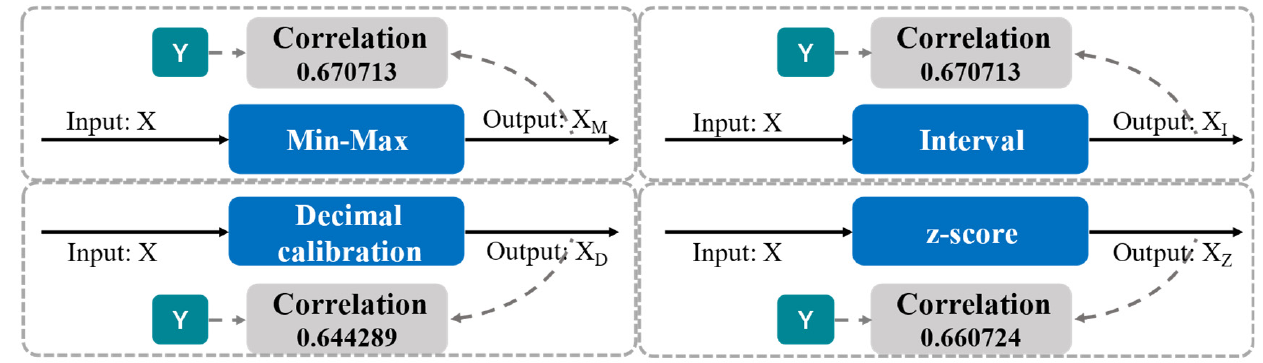
Figure 3. Schematic diagram of correlation analysis method.